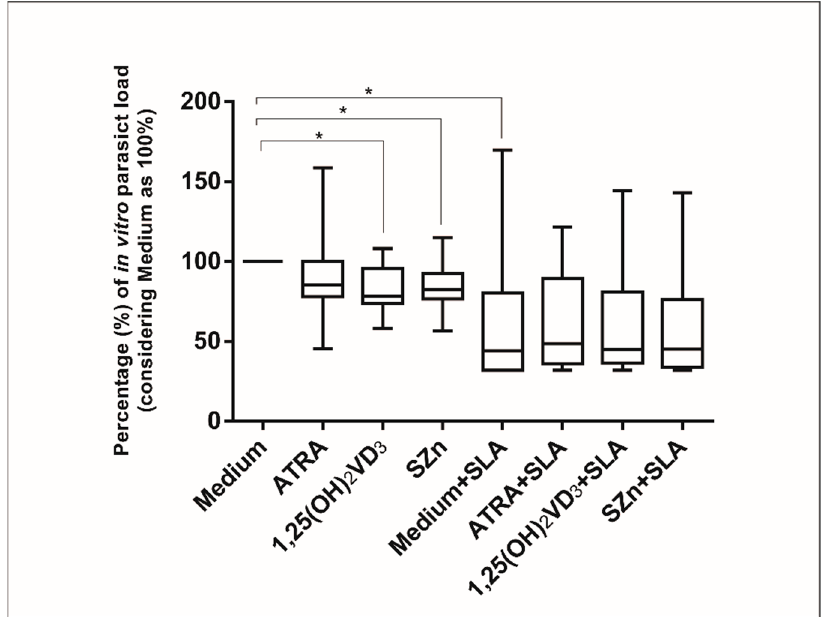
Figure 5. Parasite load in the spleen leukocytes of the CanL group supplemented with nutrients. Spleen leukocytes from dogs with CanL ( n = 15) were cultured in the medium alone or in medium supplemented with ATRA, 1,25(OH) 2 VD 3 and SZn, either with or without SLA. After 72 h, the parasite load was quantitated by counting the amastigotes present inside the infected macrophages on slides obtained by cytocentrifugation and was determined by dividing the number of amastigotes by the number of infected macrophages counted. The results are expressed as a percentage (%), considering the medium as 100% in relation to the other treatments. Bars represent the median and IQR with minimum and maximum error bars. Asterisks indicate a significant difference for the comparisons within the treatment (Wilcoxon test, * p < 0.05).